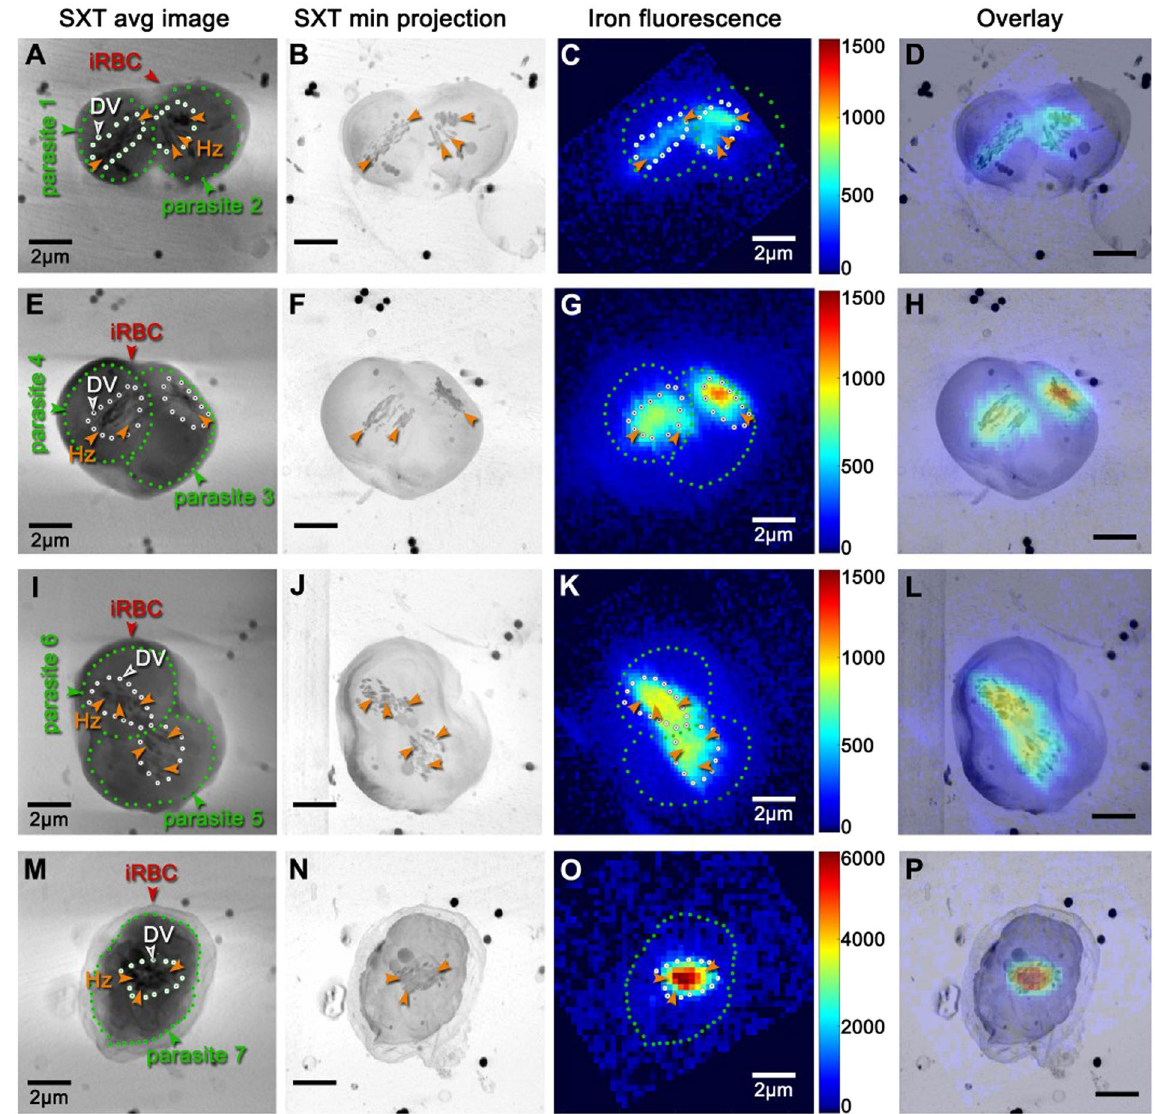
Figure 2. Correlative imaging of Plasmodium parasites by soft X-ray tomography (SXT) and scanning X-ray fluorescence (XRF). Shown are average intensity projections of four different soft X-ray tomography images (1 st column). Seven different parasites are visible (green arrows, dots and numbers) within four infected red blood cells (iRBCs) and red arrowheads). The digestive vacuole within the parasite (DV, white dots and arrowheads) can also be discerned, although precise determination of the DV boundary requires contrast adjustment of the images (Supplementary Fig. 1). Hemozoin crystals (Hz and orange arrowheads) are also visible as dark-grey spots due to strong X-ray absorption by their densely packed carbon content and iron. This high absorption enables clear detection of the crystals by computing a minimum projection of the 3D SXT images (2 nd column). We transferred these four iRBCs to the scanning XRF microscope and then collected images of iron fluorescence (3 rd column). Alignment of the SXT and XRF images was performed using the axial/in-plane alignment procedure described in the Results and Methods. This enabled transfer of the green and white dots indicating parasite and DV boundaries obtained from the SXT images to the fluorescence images. Finally, we generated overlays of the fluorescence and SXT minimum projection images (4 th column). Note that in these overlay images (4 th column) high iron fluorescence consistently overlays the Hz crystals detected by SXT. Note also that some background fluorescence can also be observed in the RBC cytosol surrounding the parasites (region between the white and the edge of the iRBC in C,G,K ). This probably reflects undigested hemoglobin in the parasite. Consistent with this, very strong iron fluorescence within the DV correlates with very low iron fluorescence in RBC cytosol ( O ), suggesting that this parasite is at a later stage where most of the hemoglobin has already been digested and the heme converted into hemozoin crystals. Scale bar 2 μ